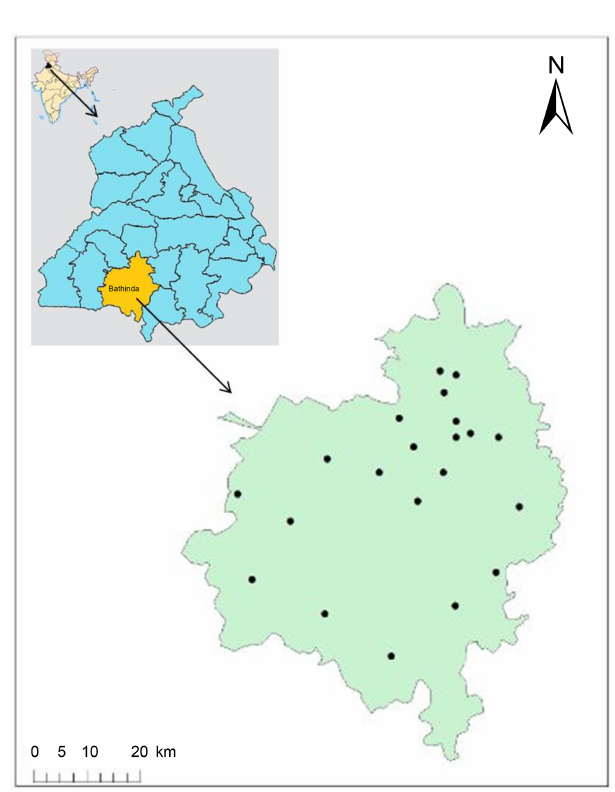
Figure 1. Sampling sites of the study area (Bathinda